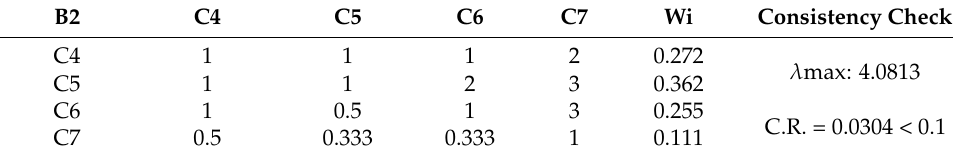
Table 11. B2–C judgment matrix and weight assignment.